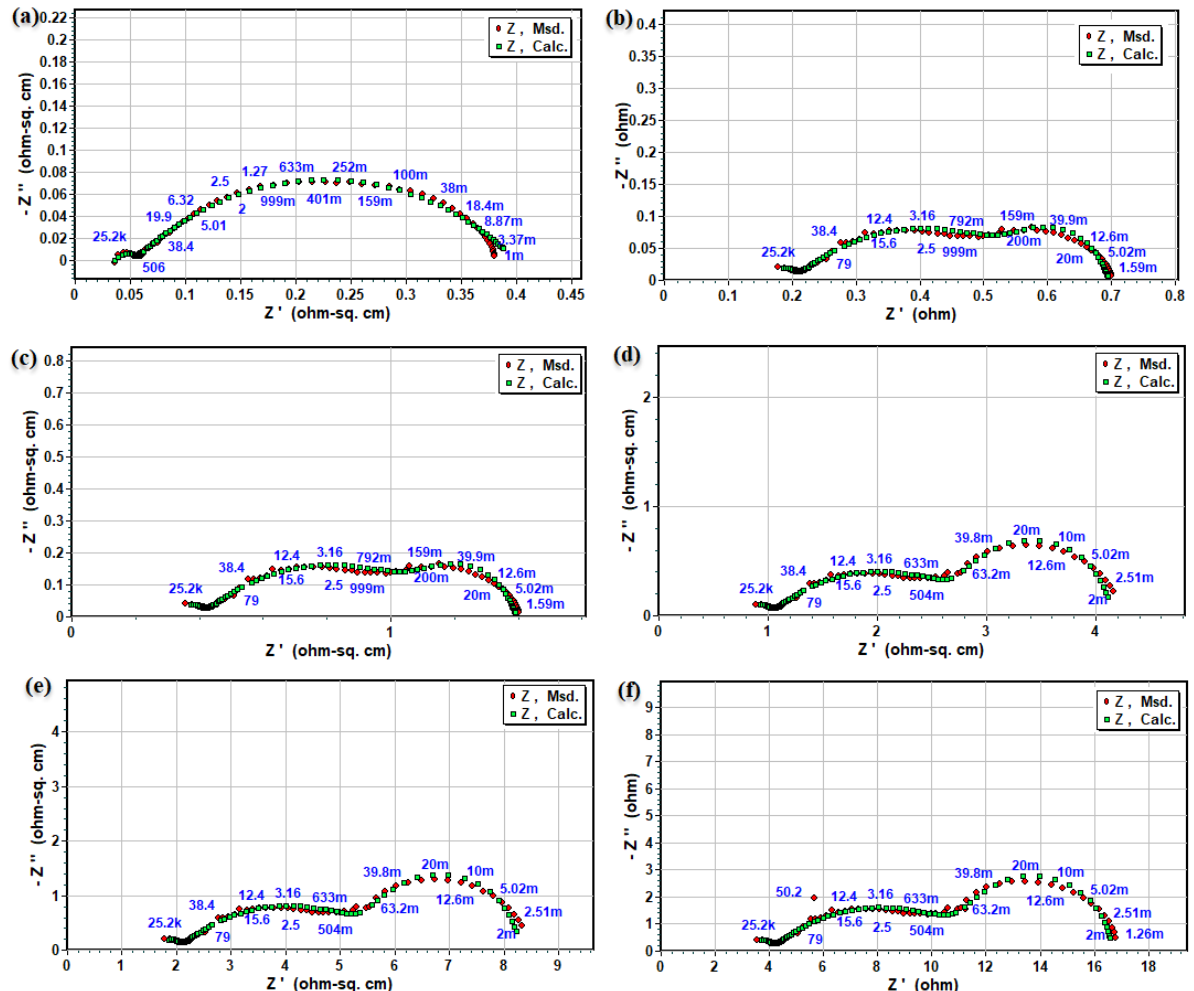
Figure 4. ( a − f ) Nyquist plot of impedance spectra for symmetrical La Fe 0. 8 Gd 0.1 Ce 0. 1 O 3- δ electrode cell cathode over SDC electrolyte different operating temperatures of 550 °C, 525 °C, 500 °C, 475 °C, 450 °C, and 425 °C,